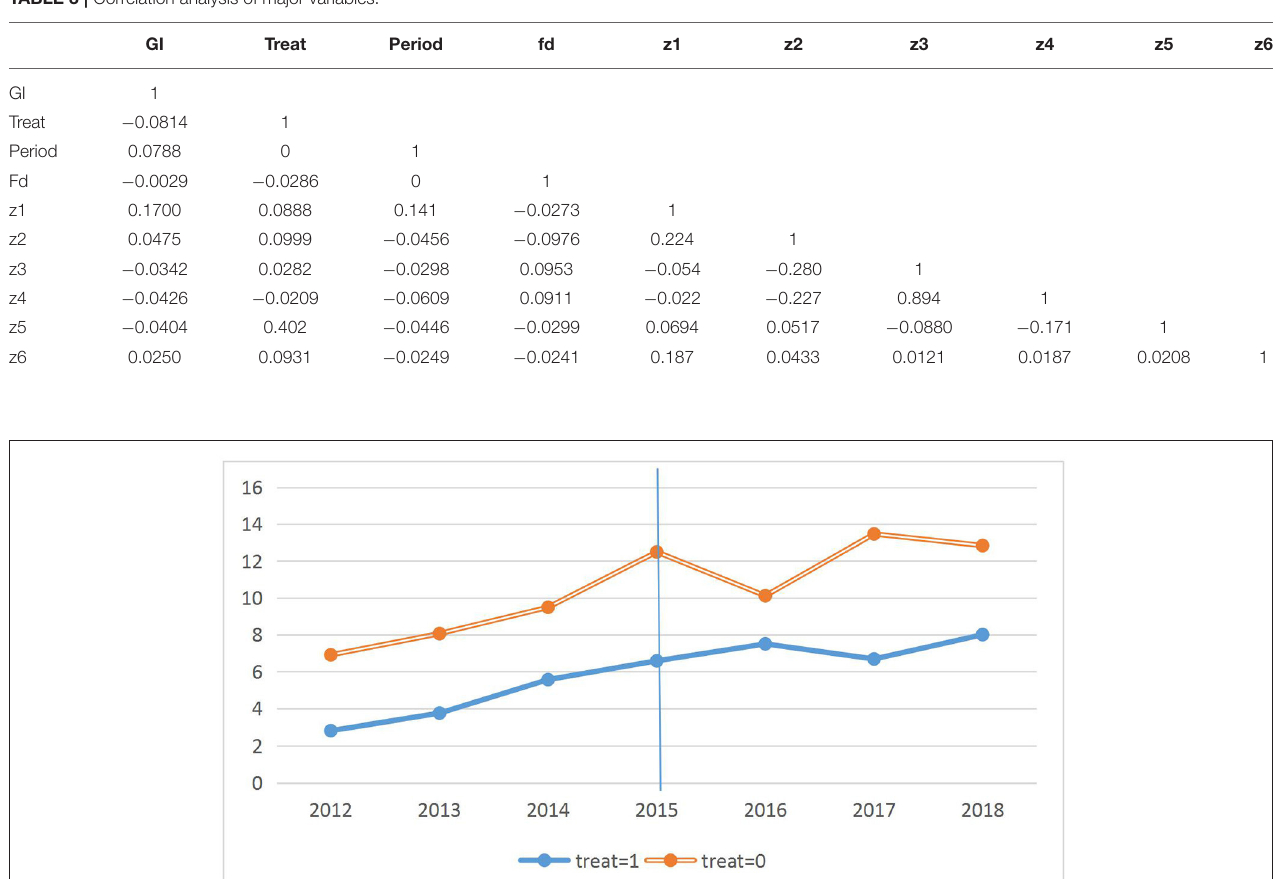
TABLE 3 | Correlation analysis of major variables.